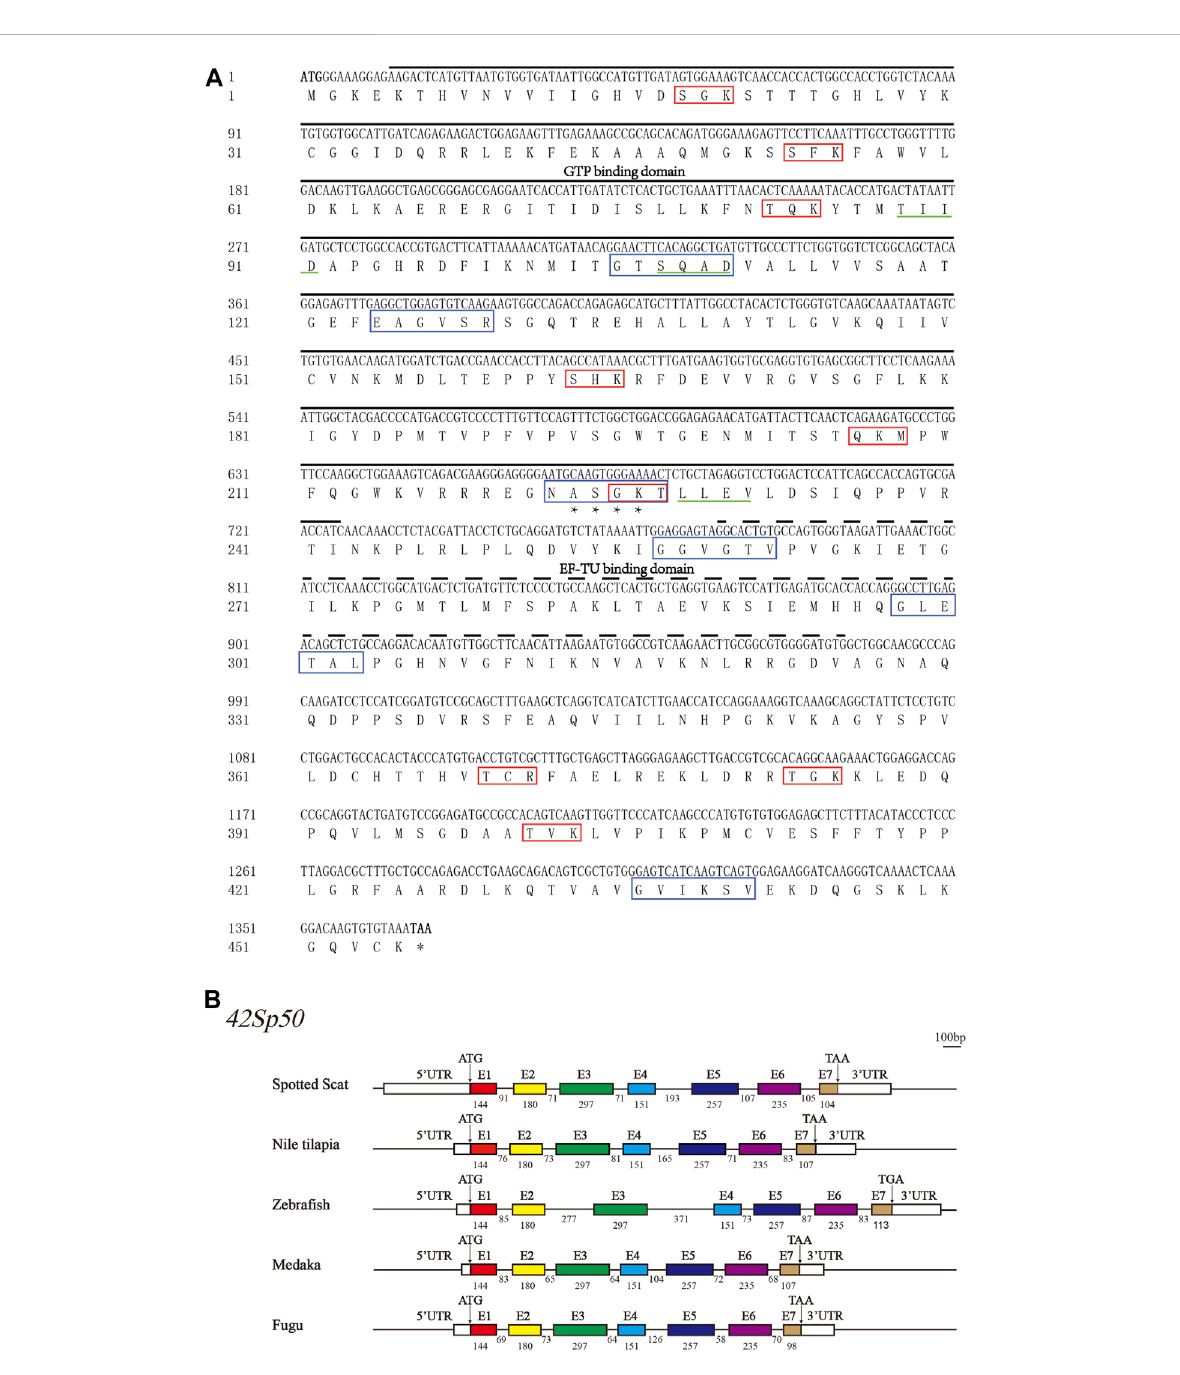
The gene sequence and structure of 42Sp50 in spotted scat ( Scatophagus argus ). (A) Nucleic acid sequence and amino acid sequence of spotted scat 42Sp50 . Black solid line, the GTP domain; Dotted line, EF-TU domain; “ * ” , N-glycosylation site; Red box, Protein kinase C phosphorylation site; Green solid line, Casein kinase II phosphorylation site; Blue box, N-myristoylation sites. (B) Schematic diagram of the exon – intronstructureof 42Sp50 inbony fi sh.Thewhiterectangles representthe5 ′ and3 ′ UTR.Coloredboxesrepresentexons, andhorizontal lines between exons represent introns. ATG stands for the start codon and TAA/TGA stands for the stop codon. The number represents the base length. The short solid lines at the top right are scale bars, representing 100